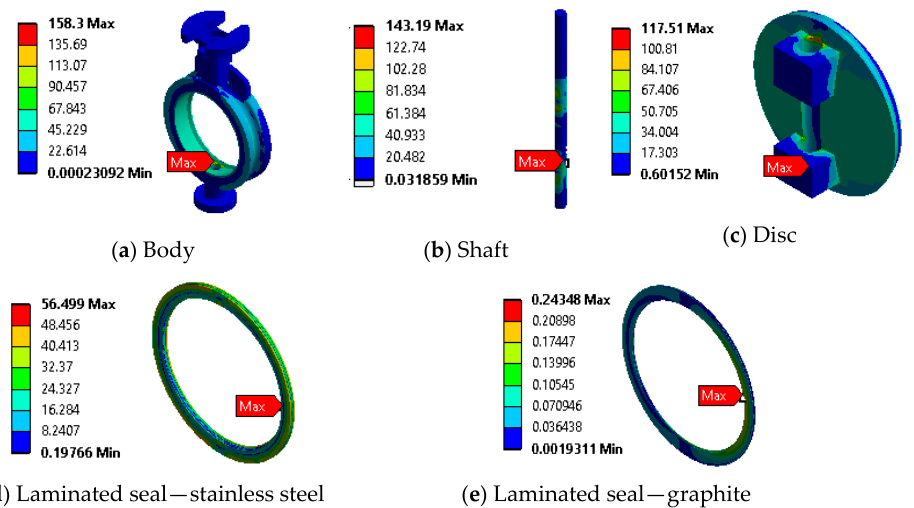
Figure 18. Equivalent stress distribution in each part of proposed model.